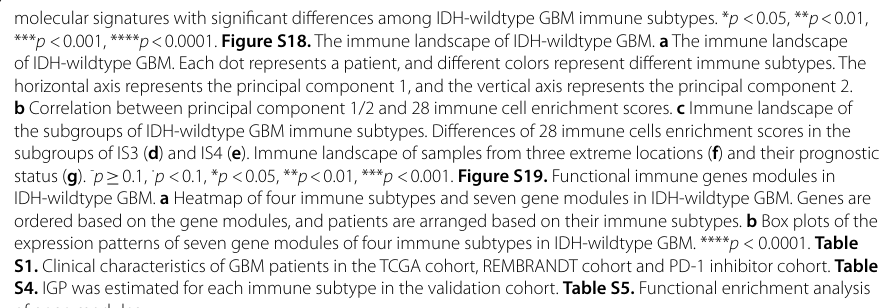
Additional file 2: Table S2 . The clinical information of TCGA cohort. Table S3. Immune-related genes. Table S6. Dif- ferentially expressed genes between responders and non-responders in pre-anti-PD-1 treatment samples. Table S7. Differentially expressed genes between responders and non-responders in post-anti-PD-1 treatment